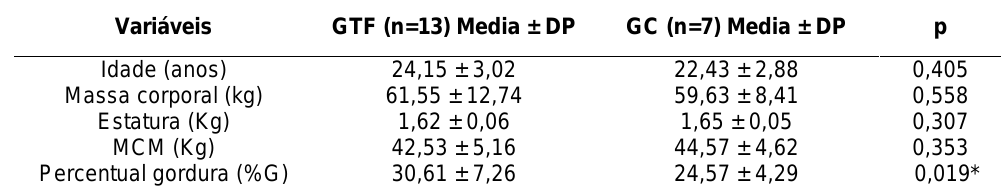
Tabela 1. Médias e desvio padrão (DP) das variáveis antropometricas idade, massa corporal, estatura, massa corporal magra (MCM) e percentual de gordura (%G) no grupo treinamento de força (GTF) e no grupo controle